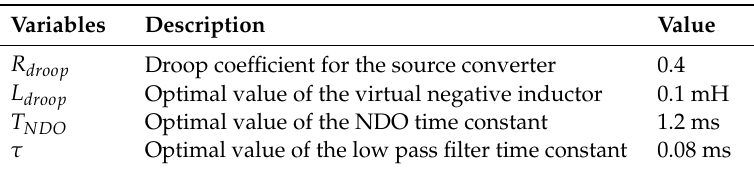
Table 2. The stabilizer parameter designing